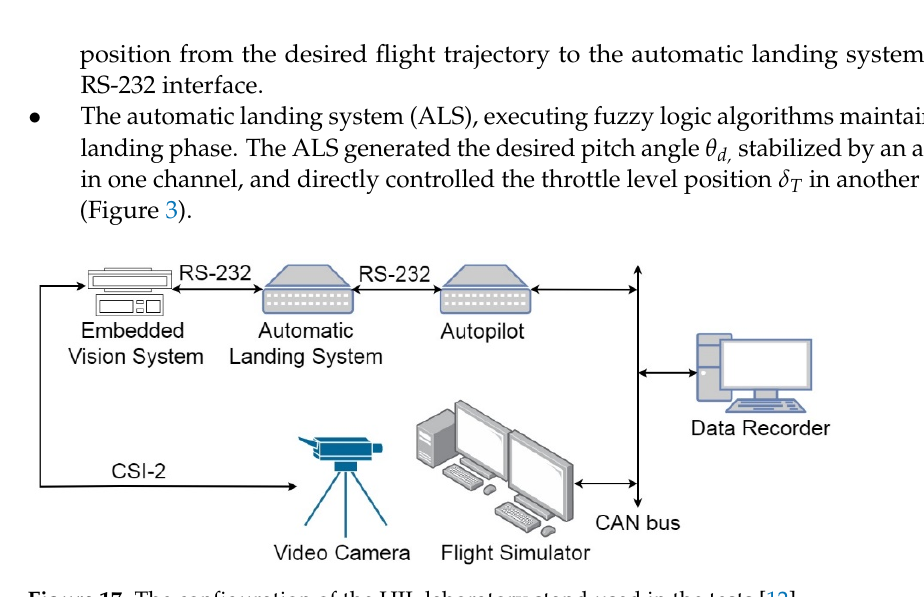
Figure 17. The configuration of the HIL laboratory stand used in the tests [12].